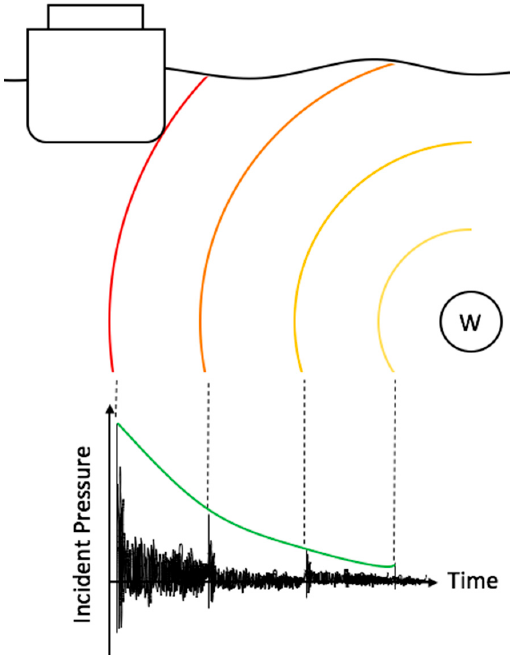
Figure 2. Successive underwater wave impacts from the explosion load (W) and incident pressure